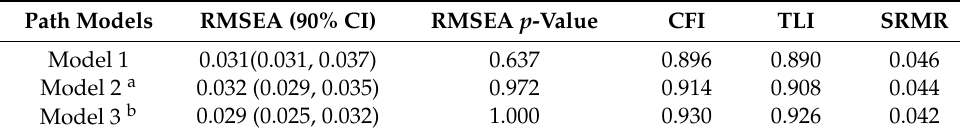
Table 1. A summary of the models’ fit indices.